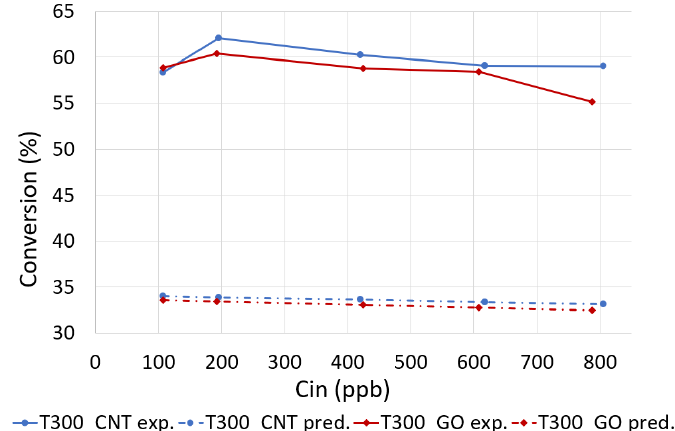
Figure 5. Experimental and predicted conversion yield of NO x for T300_GO and T300_CNT.